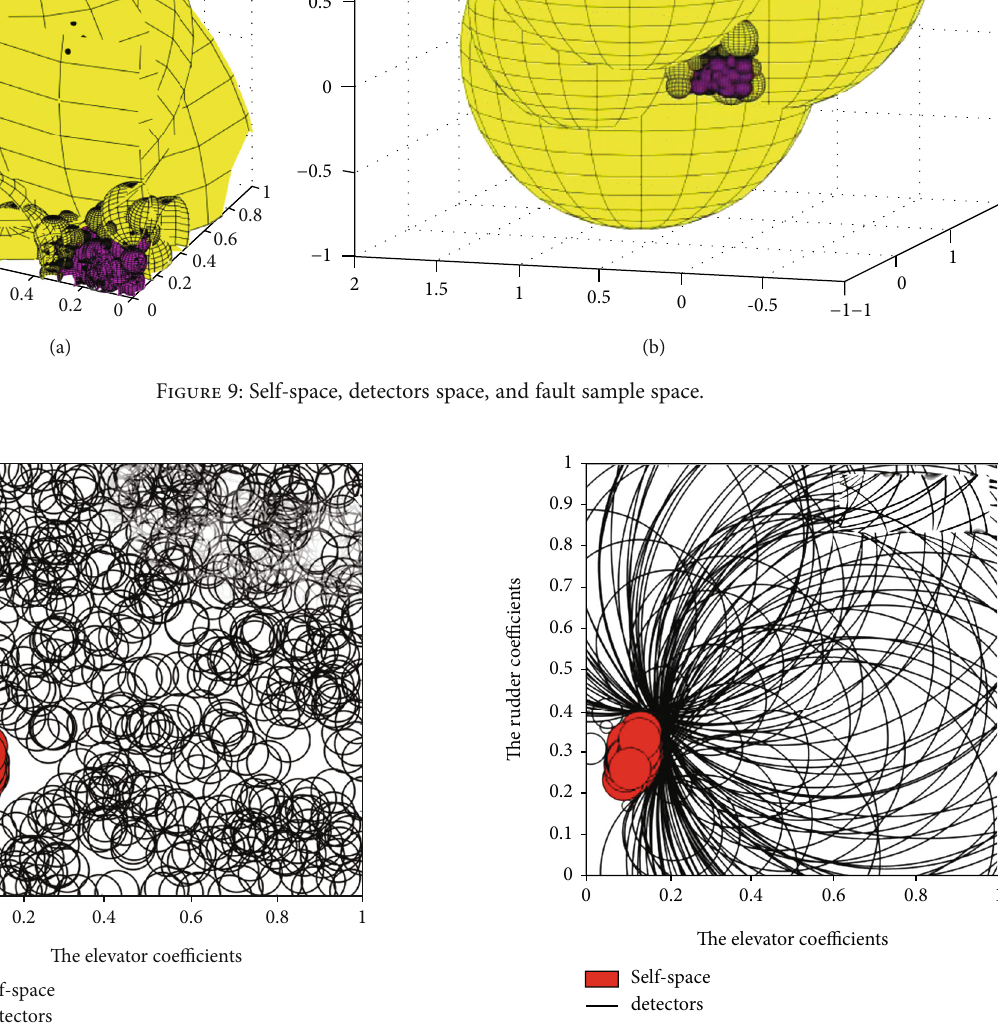
Figure 10: Detectors generation of RNSA.